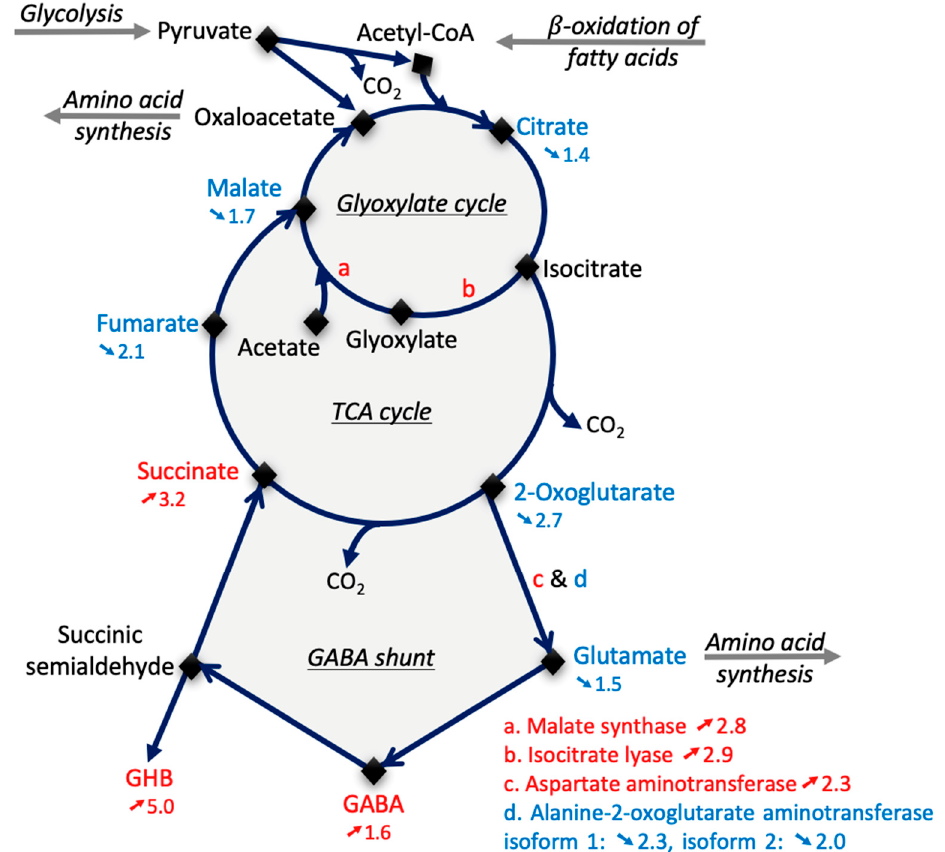
Figure 4. The energy metabolism is altered in vps29 Arabidopsis thaliana seeds. Numbers preceeded by an upward or downward arrow indicate the vps29 / Col-0 positive (in red) or negative (in blue)